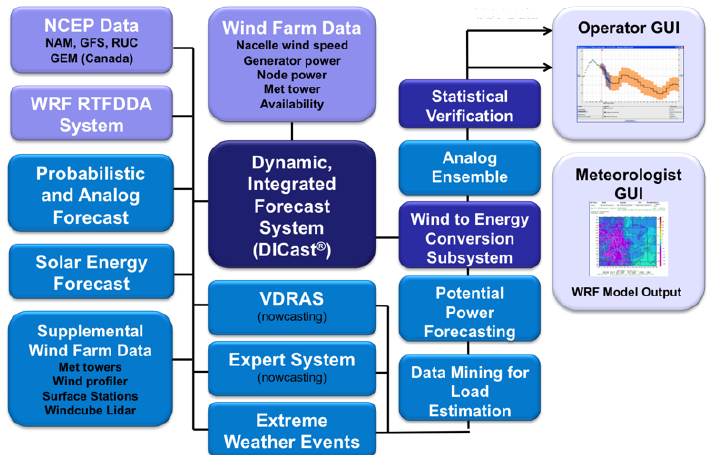
Figure 1. Flowchart of the National Center for Atmospheric Research’s (NCAR’s) Xcel Energy power prediction system. NCEP: U.S. National Centers for Environmental Prediction, NAM: North American model, GFS: global forecasting system, RUC: Rapid Update Cycle, GEM Global Environmental Multiscale model, WRF RTFDDA: Weather Research and Forecasting-based real-time four-dimensional data assimilation, and VDRAS: variational doppler radar analysis